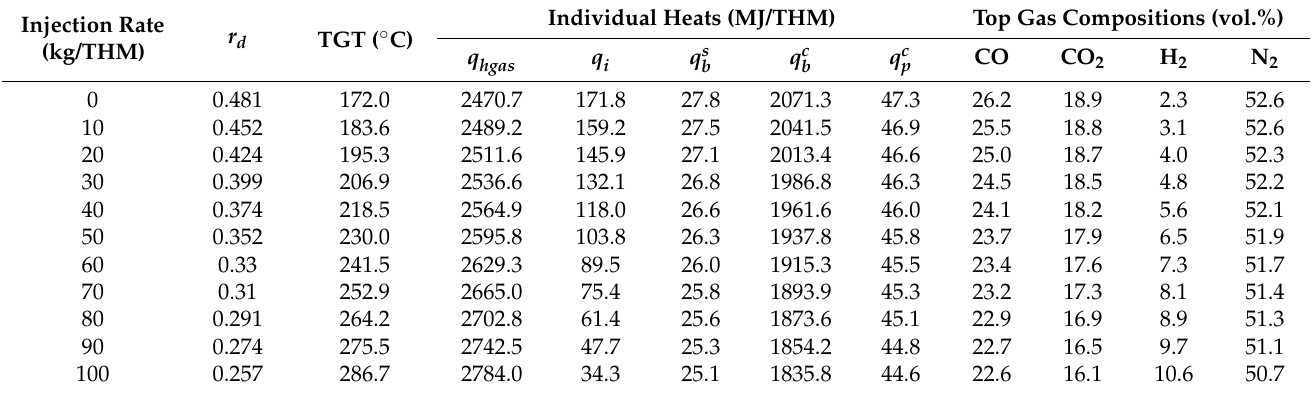
Table A1. Relevant parameter values in the calculation of TGT (injection of shale gas).